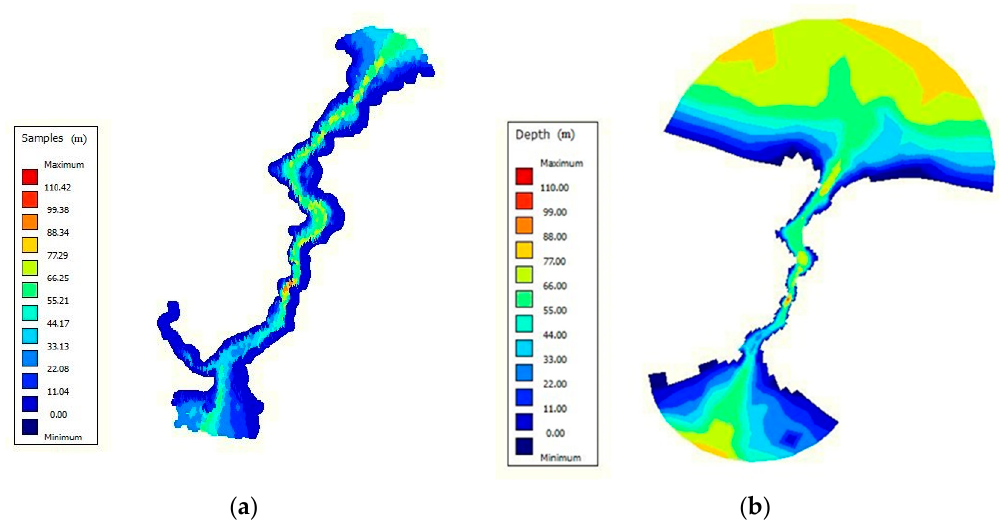
Figure 5. Hydrodynamic grid of the model in the ( a ) vertical and ( b ) horizontal directions.